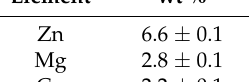
Table 1. The chemical composition of the gas atomized Al7075Zr alloy determined by XRF. Element